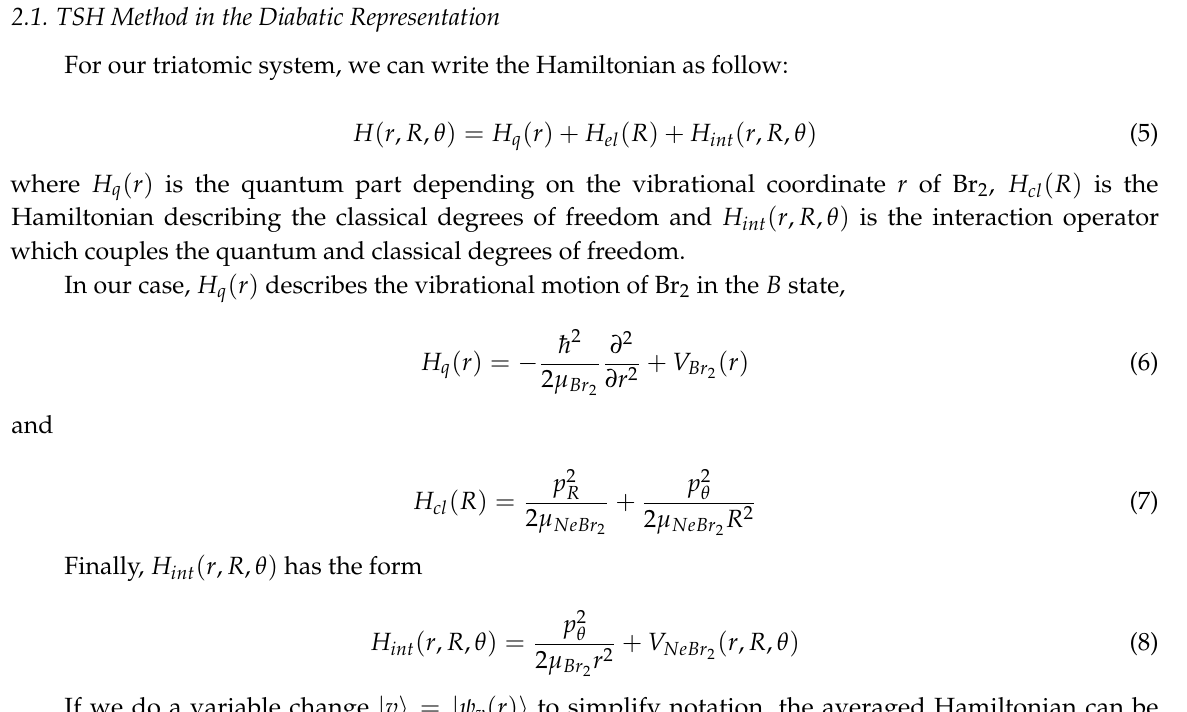
Figure 2. Schematic figure of the van der Waals interaction. The curves are calculated for the “T” shaped configuration ( θ = 90 ◦